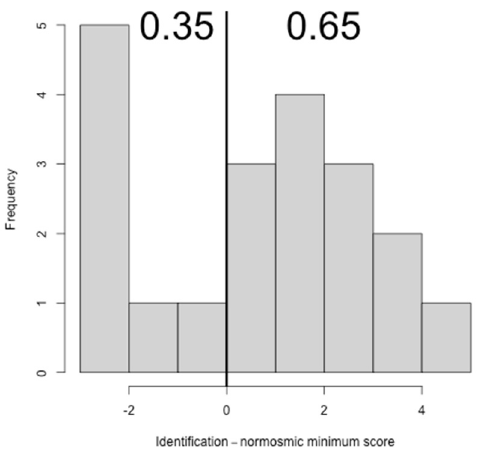
Figure 3. Histogram showing the difference between discrimination (D) scores and the normosmic minimum discrimination score.